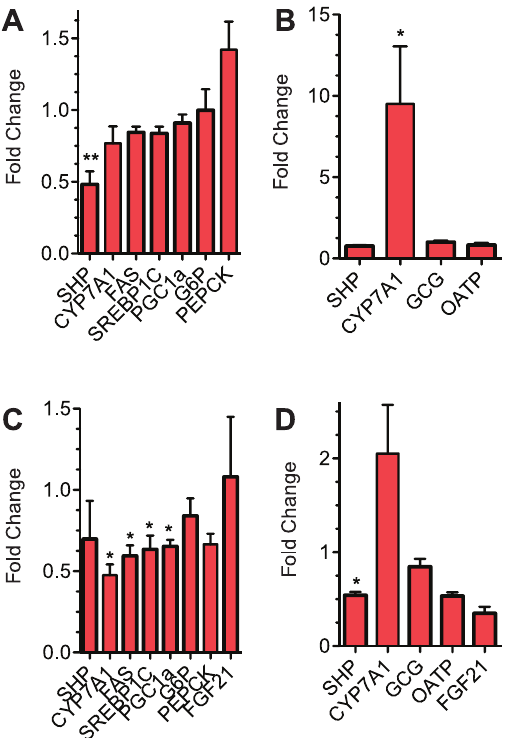
Figure 8. Gene expression changes caused by cGFJ. Mice were allowed to drink 50% cGFJ or control water for 17 or 100 d, as described in the legend of Fig. 2. A) liver, short term; B) small intestine, short term; C) liver, long term; D) small intestine, long term. Values were normalized to control values set as 1: * P , 0.05.